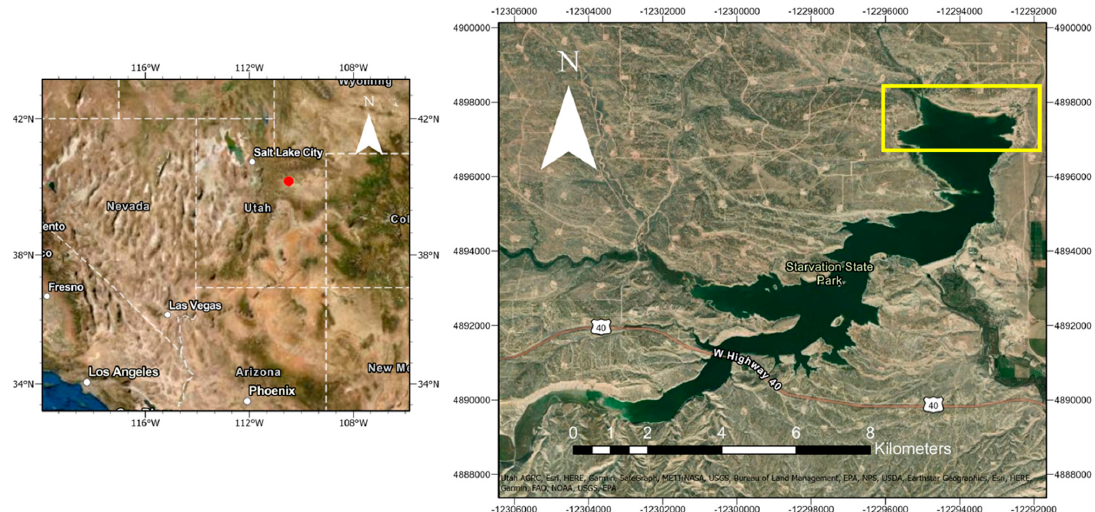
Figure 2. Starvation Reservoir in northern Utah, USA. The red dot represents the study site within Utah. A 3.2-km (2-mile) test strip (highlighted in yellow) of the northeast shoreline was created to test the effects of different GCP spacing on the accuracy of an SfM model of the shoreline, discussed in Section 3.2.